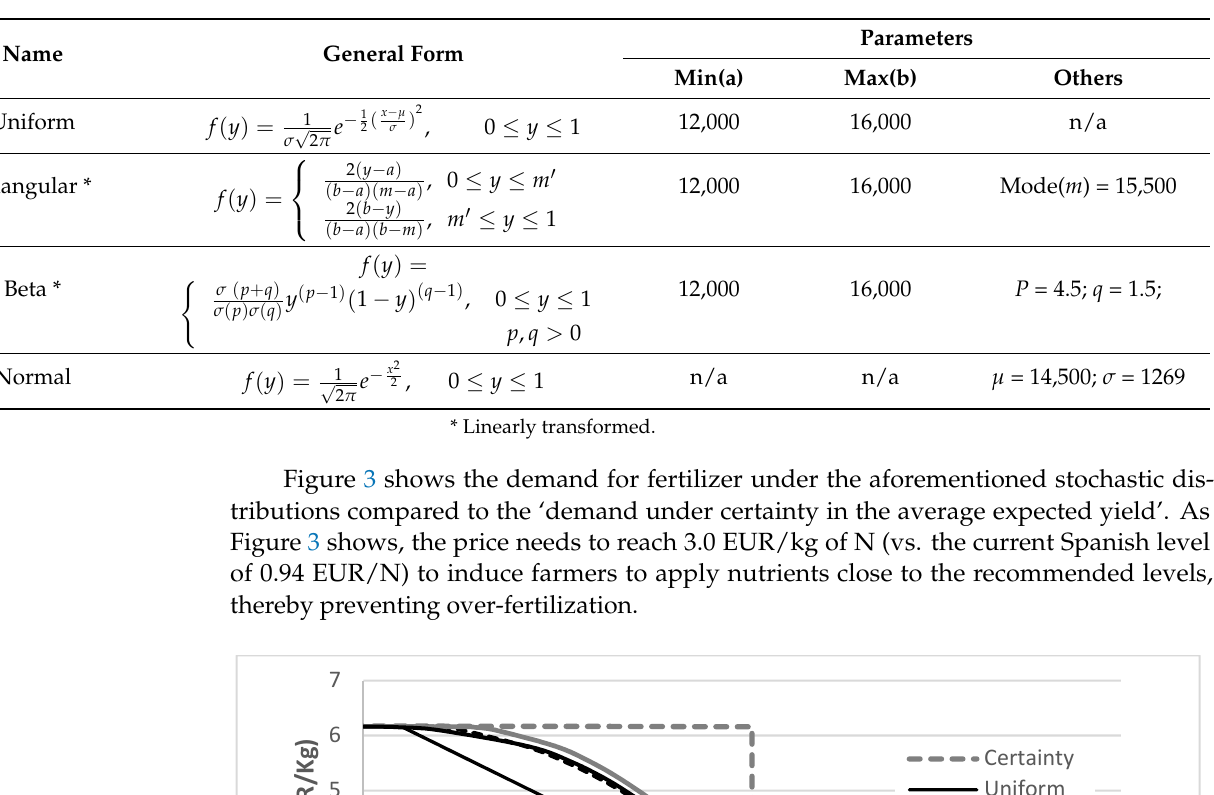
Table 1. Probability Distribution Functions. General form and parameters.